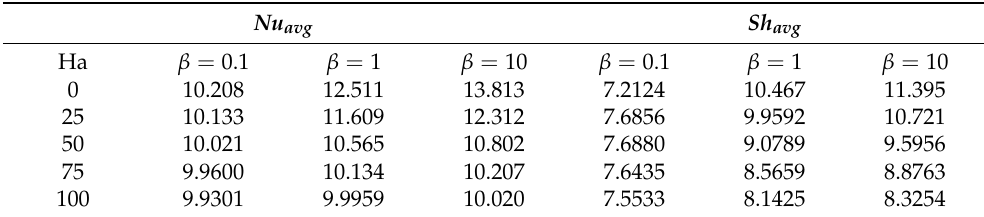
Table 4. Changes in the average Nusselt and Sherwood numbers in relation to the Casson parameter ( β ) and the Hartmann number